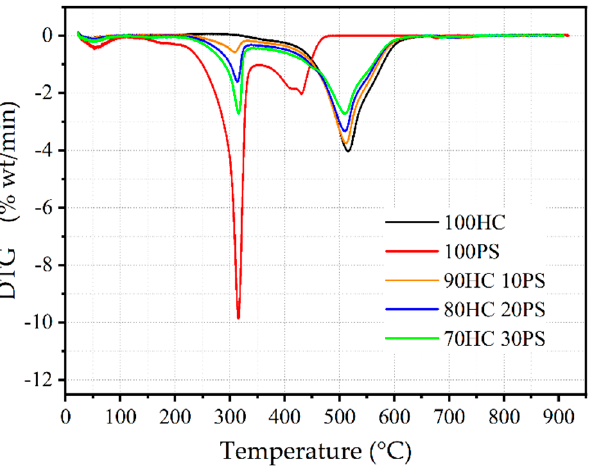
Figure 4. DTG for all fuel samples at 5 °C/min heating rate under an air atmosphere.